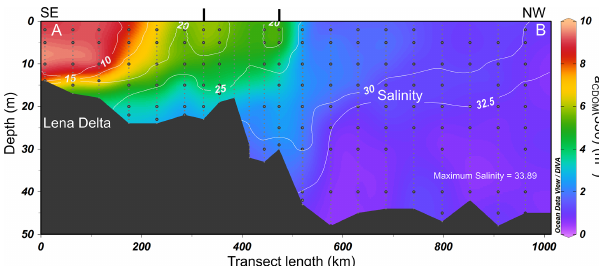
Figure 6. Salinity (white isoline) and a CDOM (350) (colour) on a ∼ 1000km long oceanographic transect from the Lena Delta (left) to the northwestern LS (September 2010; NE10). For the location of the profile see Fig. 1. Small gray dots represent salinity measure- ments (metre averaged), and black dots indicate water sampling for CDOM analysis. The figure was prepared with Ocean Data View (ODV) using DIVA gridding (Schlitzer, 2002). The black bars at the top of the panel indicate the changes in the direction of the transect (see Fig.